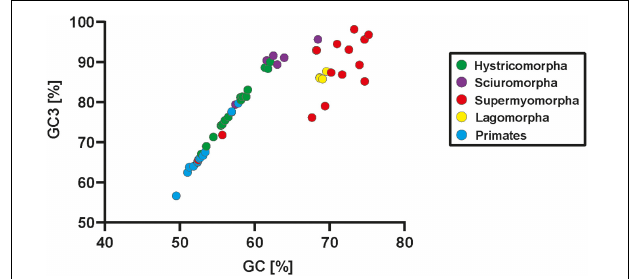
FIGURE 4 | Changes in GC-content are a characteristic of supermyomorpha and lagomorpha. The general percentage of GC-content (X-axis) of the coding region as well as the percentage of the GC3 content (Y-axis), i.e., codons with GC in the third position, are displayed in an XY scatter blot. Each data point represents a single primate, rodent or lagomorph species that had already been used to infer the evolutionary tree in Figure 3 . Primates and lagomorphs are represented in a single color, rodents have been further subdivided into their three suborders with individual colors. All primate and hystricomorpha species, most sciuromorpha species as well as the supermyomorpha species C. canadensis and N. galili follow a tight GC/GC3 relationship with a similar slope whether they encode NLGN4X or NLGN4Y genes. Some sciuromorpha, all lagomorphs, and most supermyomorpha species form a loose cloud with exceptionally high GC and GC3 content.